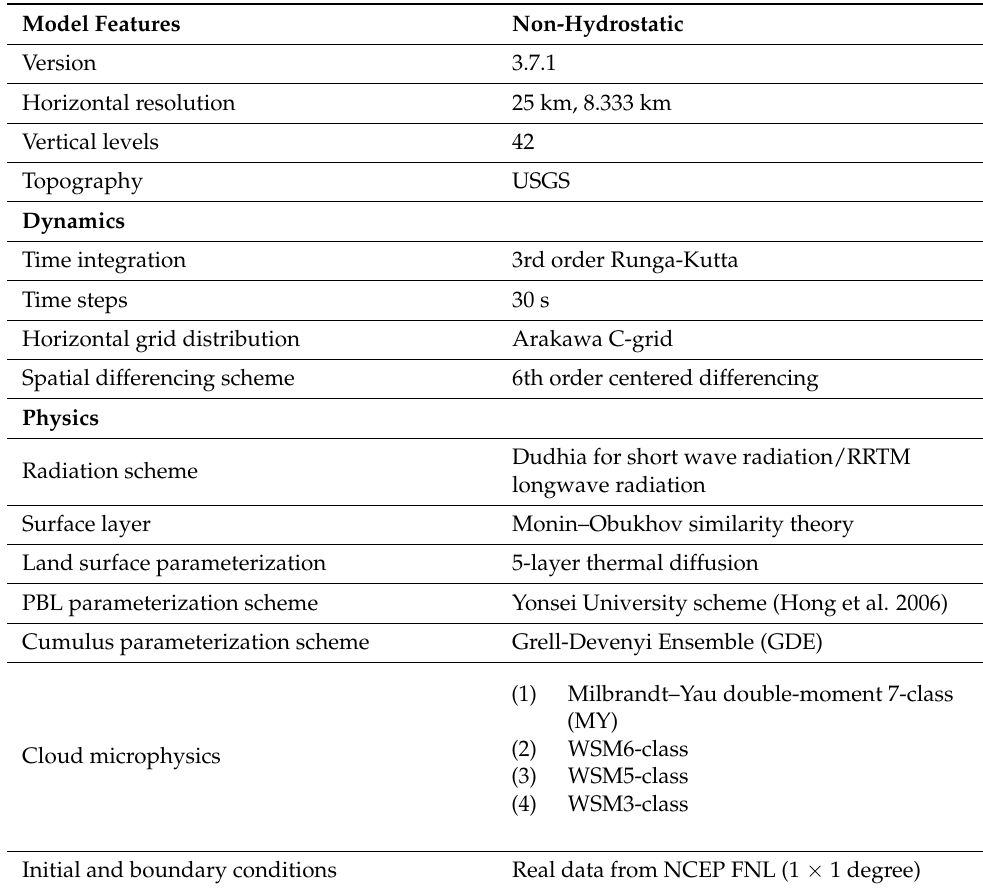
Table 2. WRF model and domain configurations.